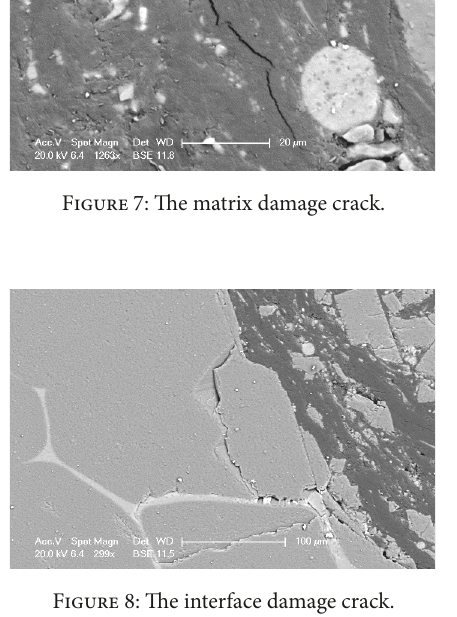
Figure 6: Computation results of the GMM algorithm ( 𝜔 1 = 0.63 , 𝜔 = 0.37 ). 2